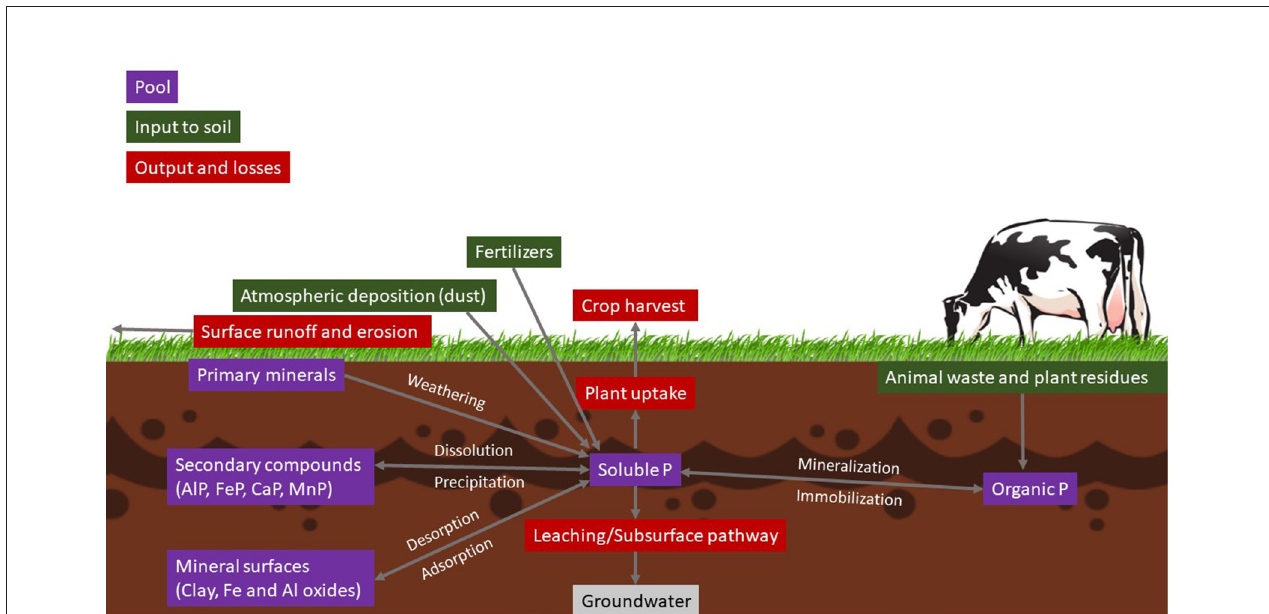
FIGURE 3 | Soil phosphorus turnover in soil and pathways of P loss to waters on agricultural landscapes.